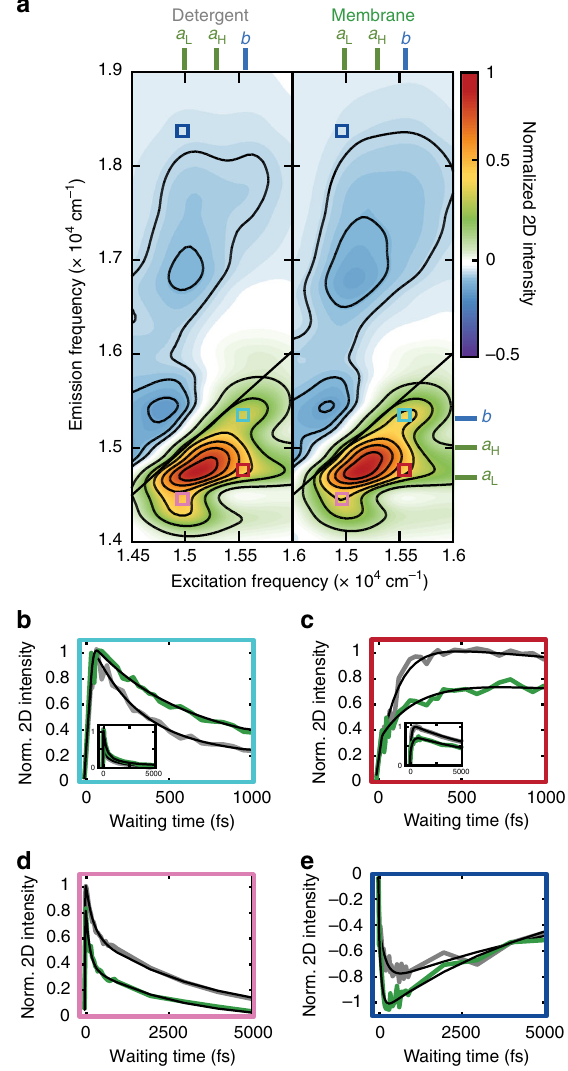
Fig. 3 Impact of the membrane environment on chlorophyll relaxation dynamics. a Absorptive 2D spectrum of LHCII in detergent (left) and in the membrane (right) in the Chl Q y region at T = 533 fs. Colored sticks indicate the energy levels of the Chl Q y states. Contour lines are drawn at 15% and 5% intervals for positive and negative signals, respectively. b – e Waiting time traces of the peaks labeled in a : Chl b diagonal peak ( b , cyan box in a ), Chl b → Chl a energy transfer cross peak ( c , red box in a ), Chl SE ( d , pink box in a ), and Car S 1 ESA upon excitation of the terminal Chls ( e , blue box in a ). Insets in b and c show longer-timescale dynamics. The traces were generated by integrating the 2D intensity over frequency intervals of 100 cm − 1 ( ω τ ) × 100 cm − 1 ( ω t ) for b , c , and 300 cm − 1 ( ω τ ) × 400 cm − 1 ( ω t ) for d , e around the following center frequencies: ( ω τ , ω t ) = (15,540, 15,300) b , (15,540, 14,750) c , (14,925, 14,470) d , (14,925, 18,400) ( e , in cm − 1